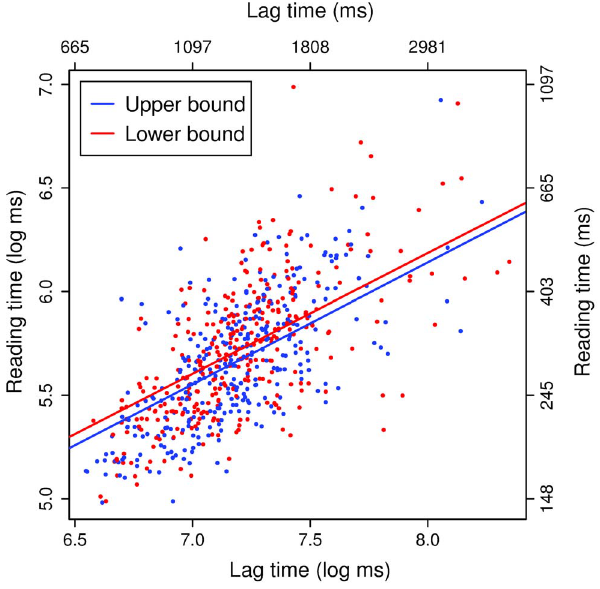
Figure 2. Reading time vs. lag time. Relationship between reading times on ‘‘the rest’’ and lag between the quantifier and ‘‘the rest’’ for upper-bound (dots and solid line) and lower-bound (triangle and dashed line) contexts. Points represent individual observations, and regression lines represent predictions from a mixed model with fixed effects of Boundedness, Lag Time, and their [non-significant] interac- tion. The bottom and left axes show log lag time and log reading time respectively, and the top and right axes show raw lag time and raw reading time.